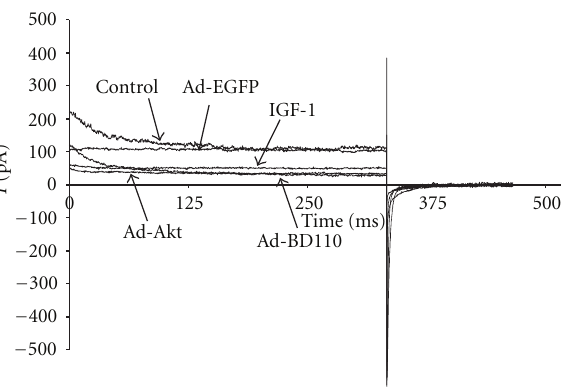
Figure 4: Recording representative of the time courses for the e ff ects of IGF-1, Ad.Akt, and Ad.BD110 in combination with LY 294002 treatments on I K of normal neonatal rat cardiomyocytes at the clamp voltage of +30mV. Current expressed as pA.